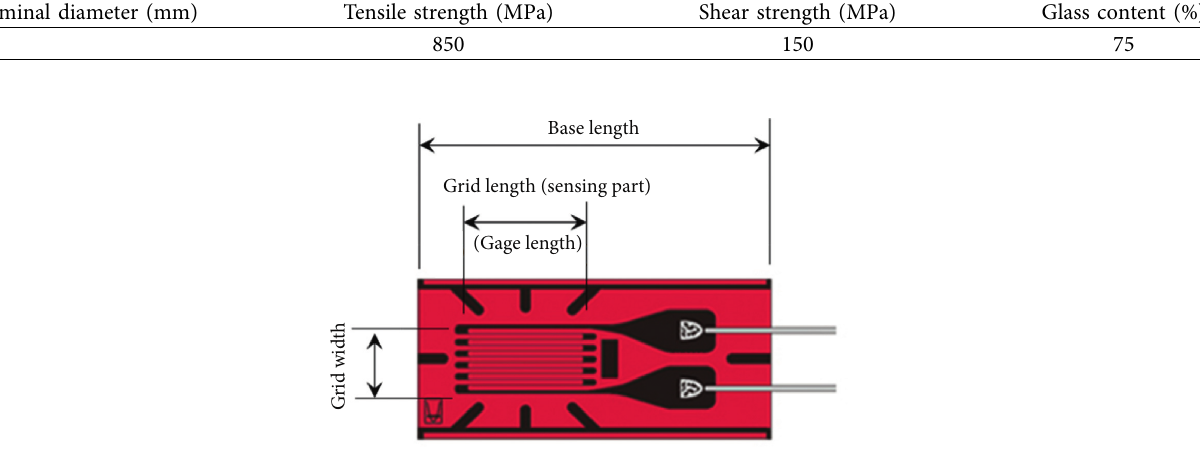
Figure 4: Strain gauge. Table 2: Specifications of strain gauge.